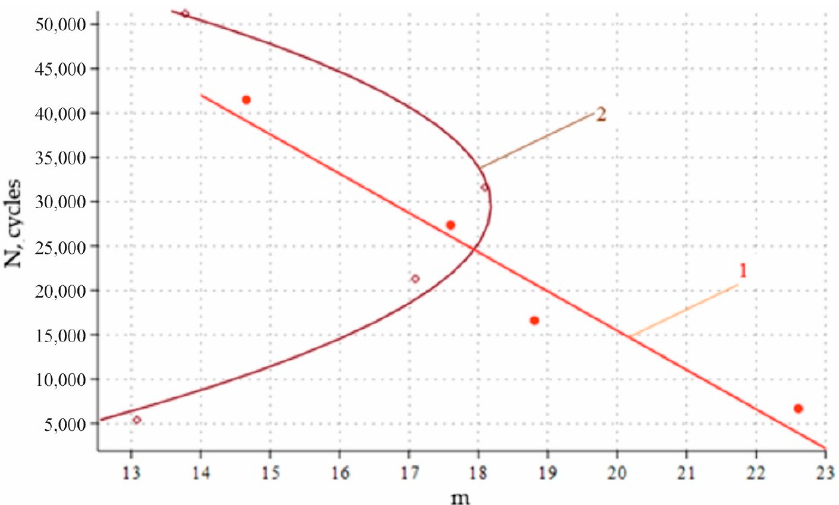
Figure 10. Comparison of experimental results on the number of cycles to fracture of aluminum alloy D16ChATW in the initial state (red dots) and after introducing impulse energy ε imp = 3.7% into the alloy (brown characters) at specified conditions of variable loading with analytical results obtained using the proposed structural and mechanical models (line 1, Equation (3); line 2, Equation (6)).